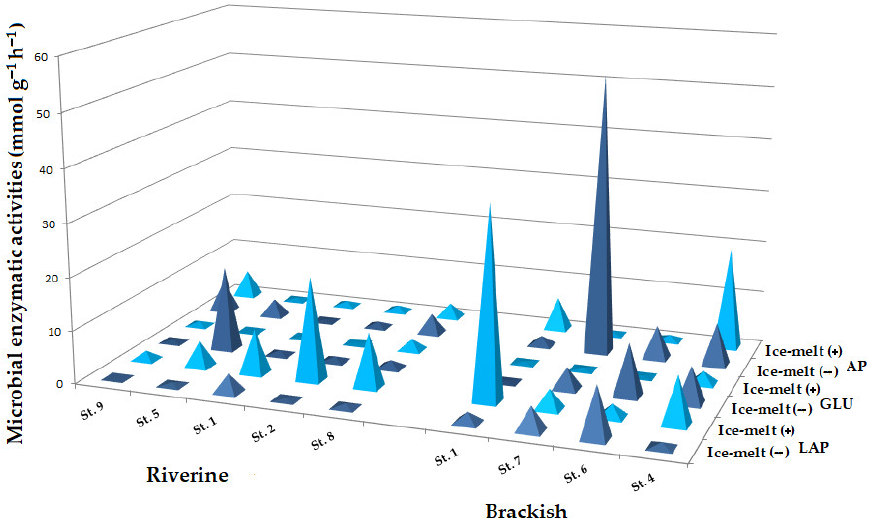
Figure 3. Enzymatic activities in sediment samples from the Pasvik River. Ice-melt(+) and Ice-melt( − ) are shown in dark and light blue, respectively.